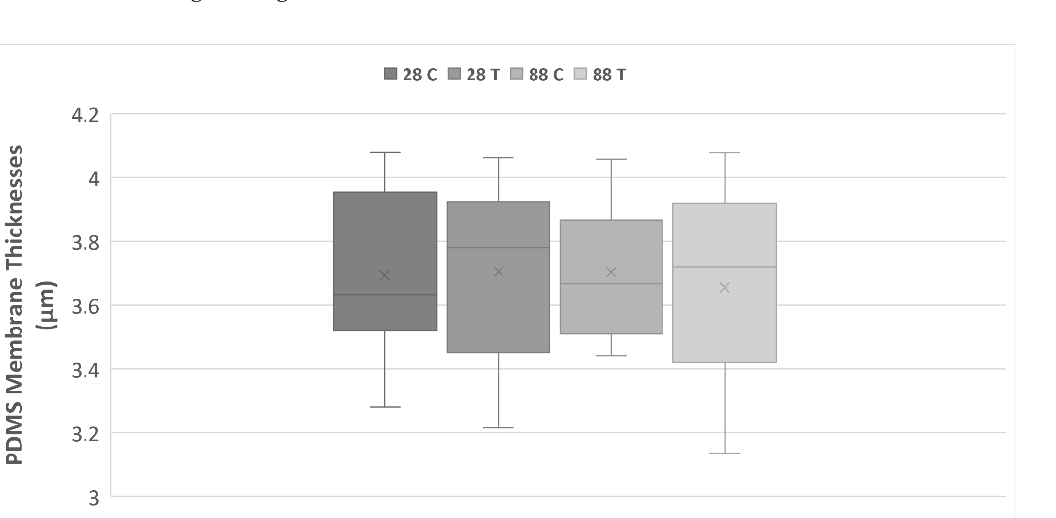
Figure 3. PDMS membrane thickness (µm) distribution for all experimental groups. The numbers 28 and 88 stand for the age of the donor which the dermal fibroblast cells were harvested from. C = Control Group and T = Training Group. The lower and upper fences are 25th and 75th percentiles, while the middle line represents the median, and the letter X stands for the sample average. The lower and upper whiskers show the minimum and maximum sample values, respectively.